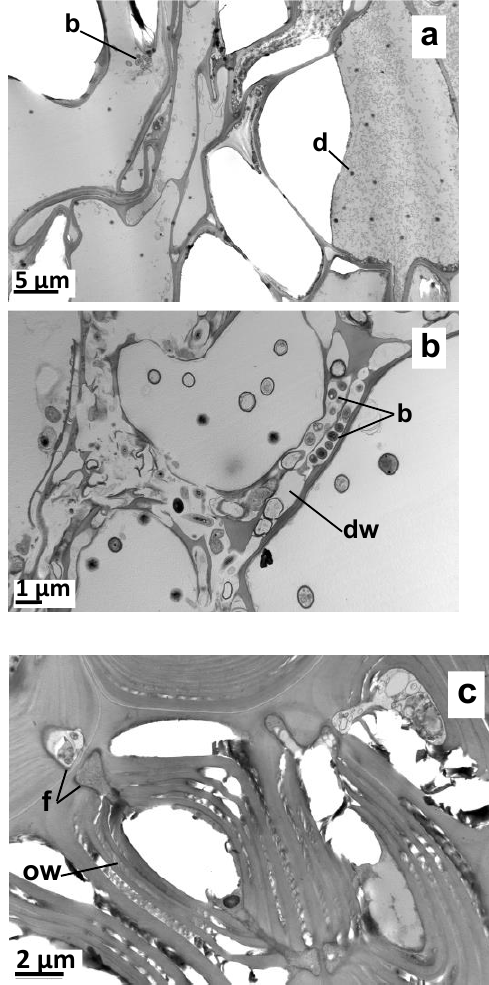
Figure A1. TEM views of microorganisms in root sections. ( a ) Bacteria near the cortical parenchyma cells in aeroponic plant roots. ( b ) Bacterial lysis in root cell walls of potted plants. ( c ) Fungi in ligneous parenchyma cells of potted plants. b: Bacteria; d: EO droplet; f: fungus; dw: degraded cell wall; ow: onion-like structure of the cell wall.